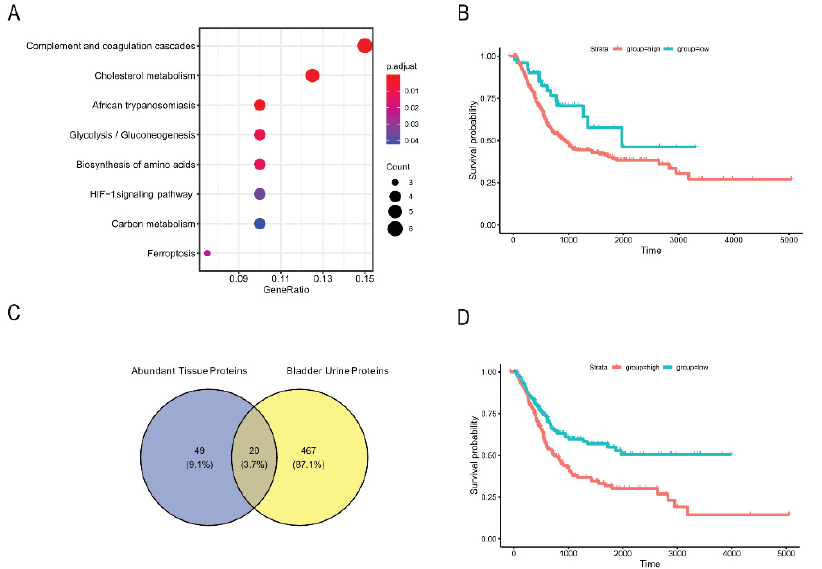
Figure 4. Functional characterisation of the most abundant tissue proteins unrelated to site of origin. ( A ) Enrichment plot showing enriched pathways among proteins that are present in all tissue samples and do not differ significantly by site of origin. ( B ) Kaplan–Meier plot showing the survival of 399 bladder cancer patients [20], separated by their mRNA expression of the 69 most abundant tissue proteins found in this study. ( C ) Venn diagram of proteins enriched in tissue exosomes (distant tissue and original tumour site) and proteins enriched in exosomes from bladder urine compared to ureter urine. ( D ) Kaplan–Meier plot showing the survival of 399 bladder cancer patients [20], separated by their mRNA expression of the 20 proteins upregulated in exosomes derived from bladder vs. ureter urine [15] and being present among the 69 most abundant tissue proteins found in this study.